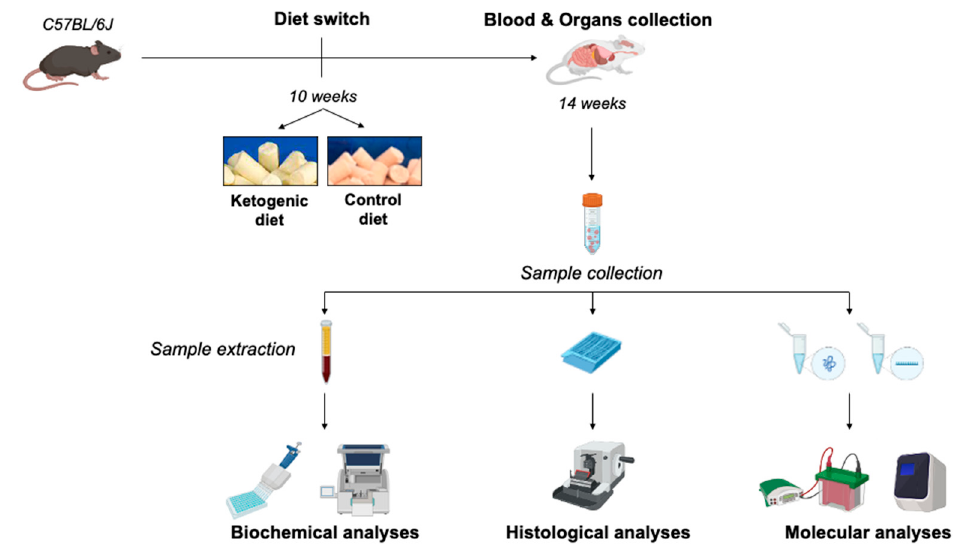
Figure 7. Schematic illustration of experimental design of the study.